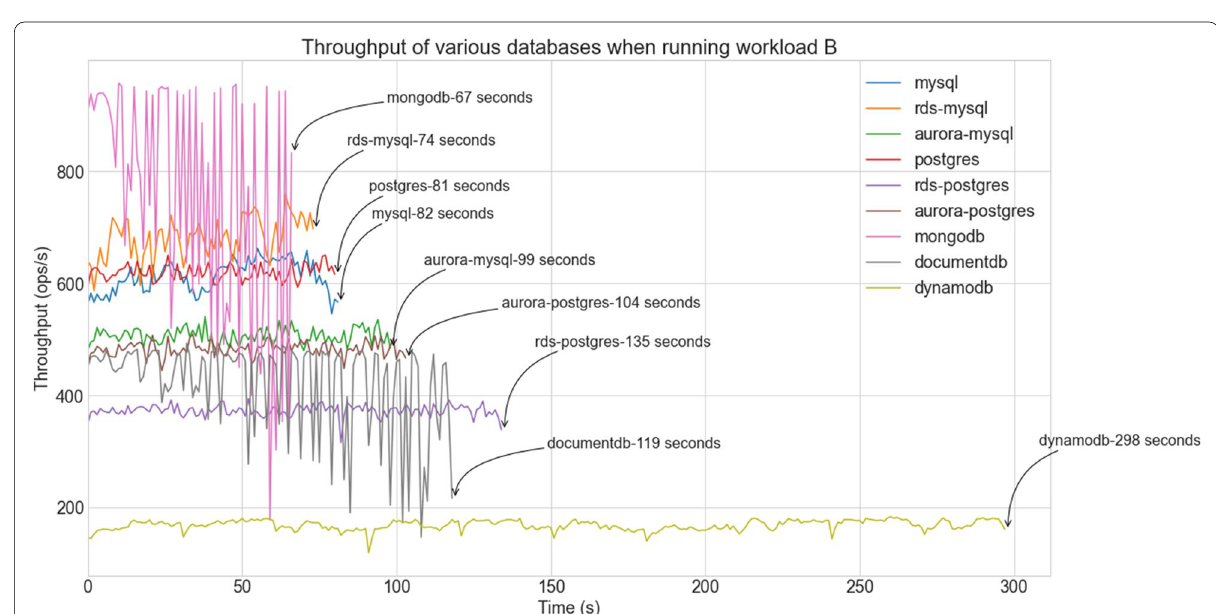
Fig. 7 Performance of databases with Workload‑b (equal number of reads and updates)